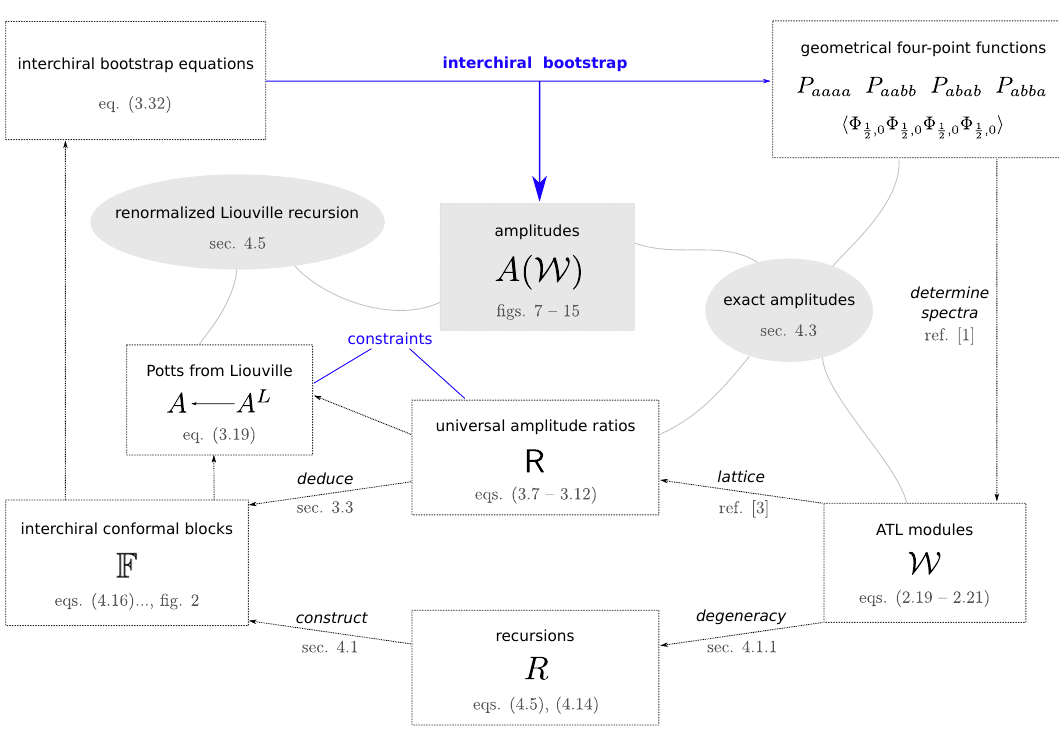
Figure 1 . Chart of the contents of this